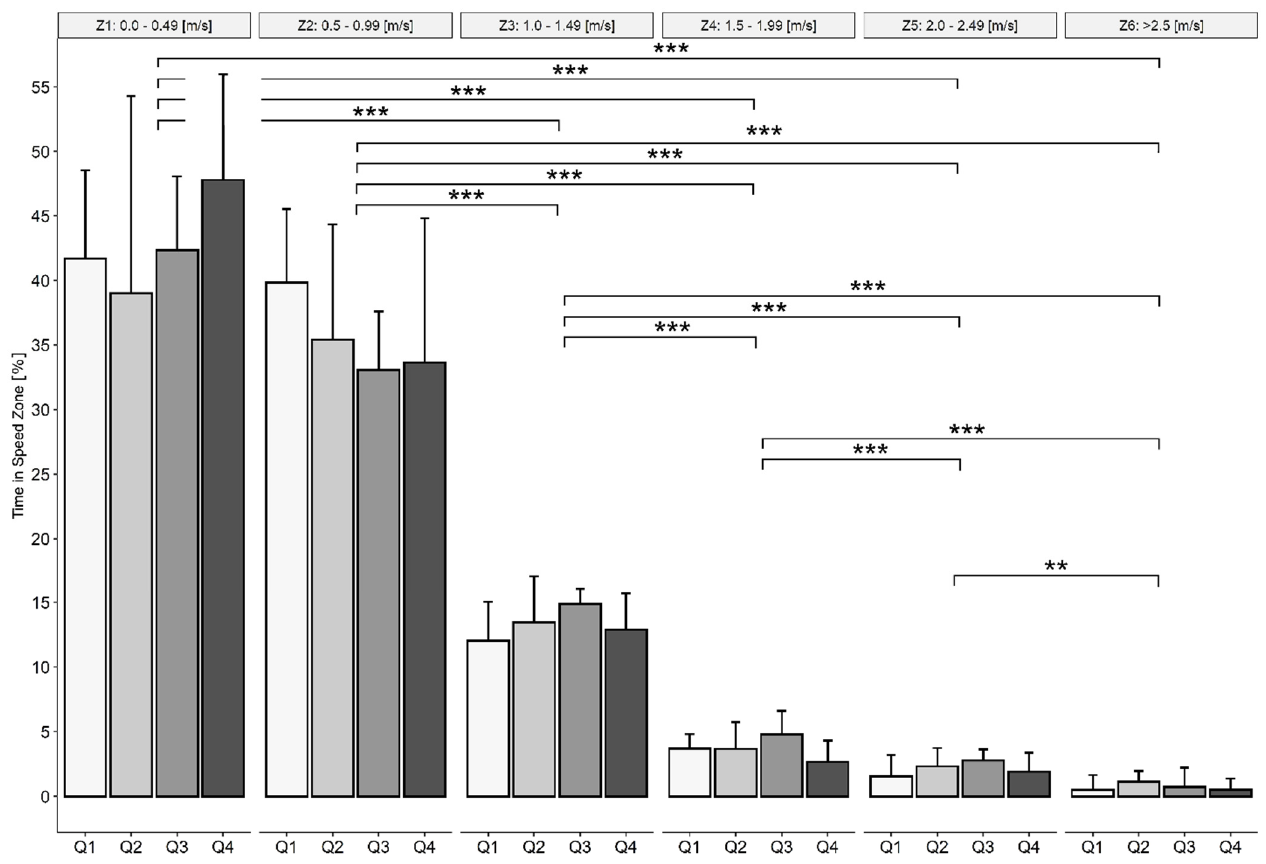
Figure 3. Percentage of time spent in different speed zones (Z), median ± interquartile range (IQR), *** significantly different from other zones ( p < 0.001), ** significantly different from other speed zone ( p = 0.002).